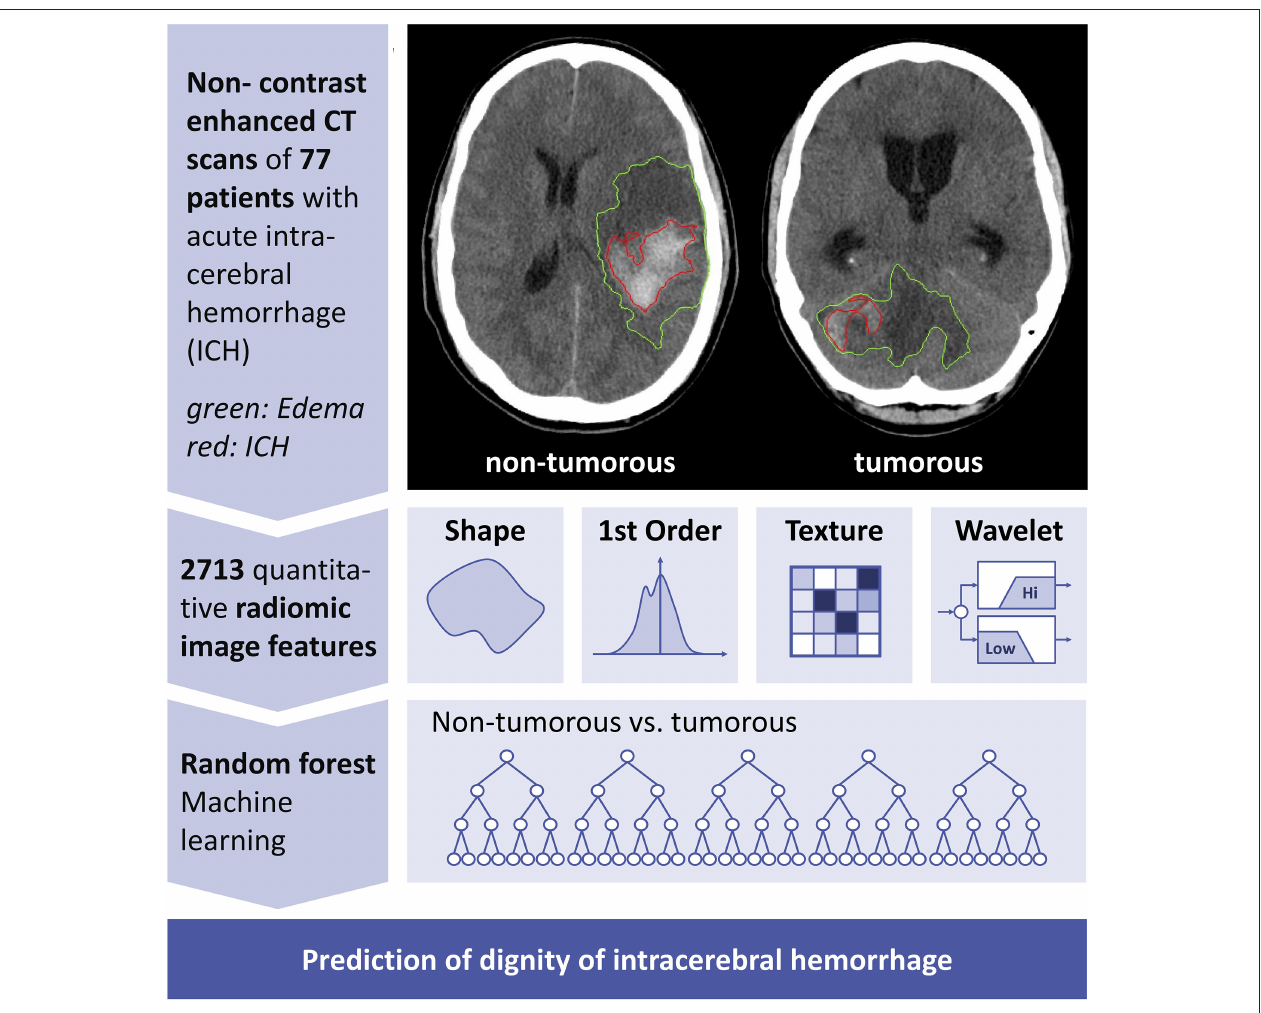
FIGURE 1 | Conceptual overview of proposed neoplastic intracerebral hemorrhage prediction. Conceptual overview of the proposed machine learning approach showing the major processing steps: CT-based image acquisition and segmentation, feature extraction ( n NECT, non-contrast-enhanced computed tomography; ICH, intracerebral hemorrhage; PHE, perihematomal